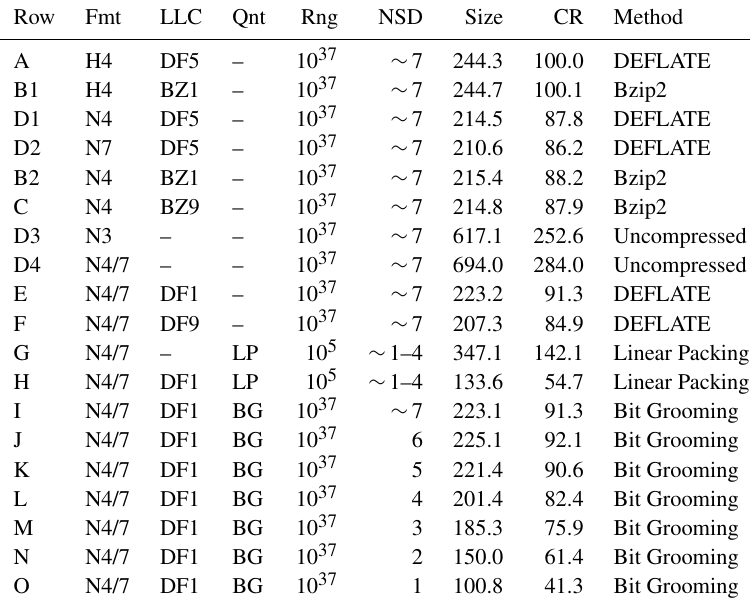
Table 6. Compression ratios for high-resolution initially compressed observed HDF4 data.